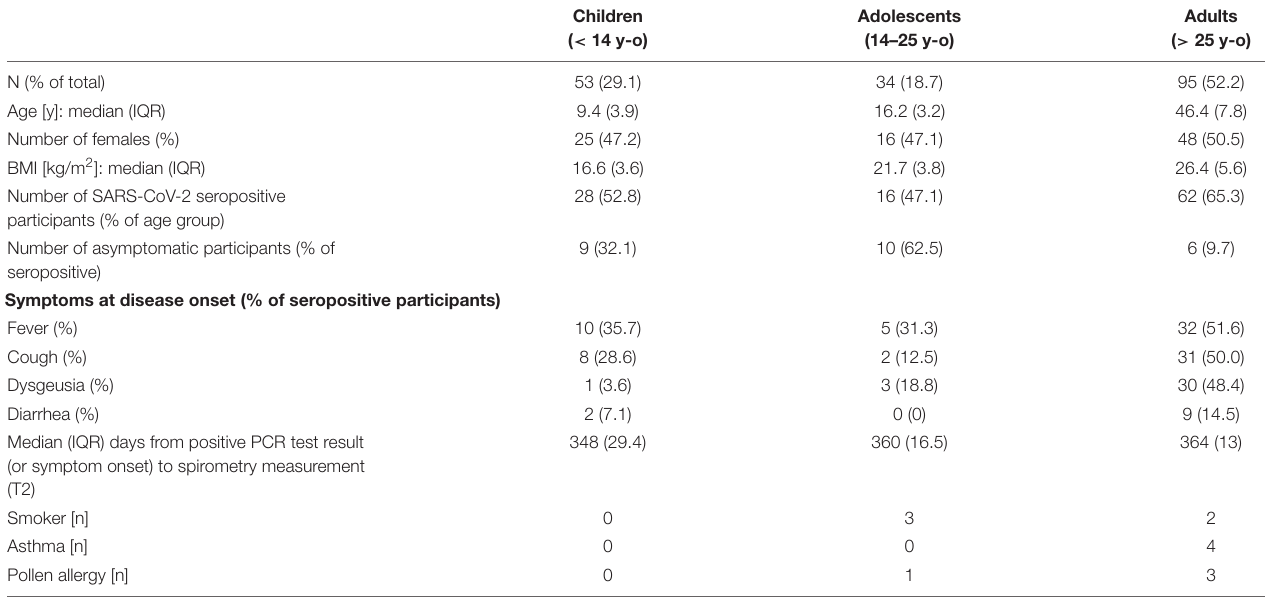
TABLE 1 | Demographics and key serologic and clinical information on the study